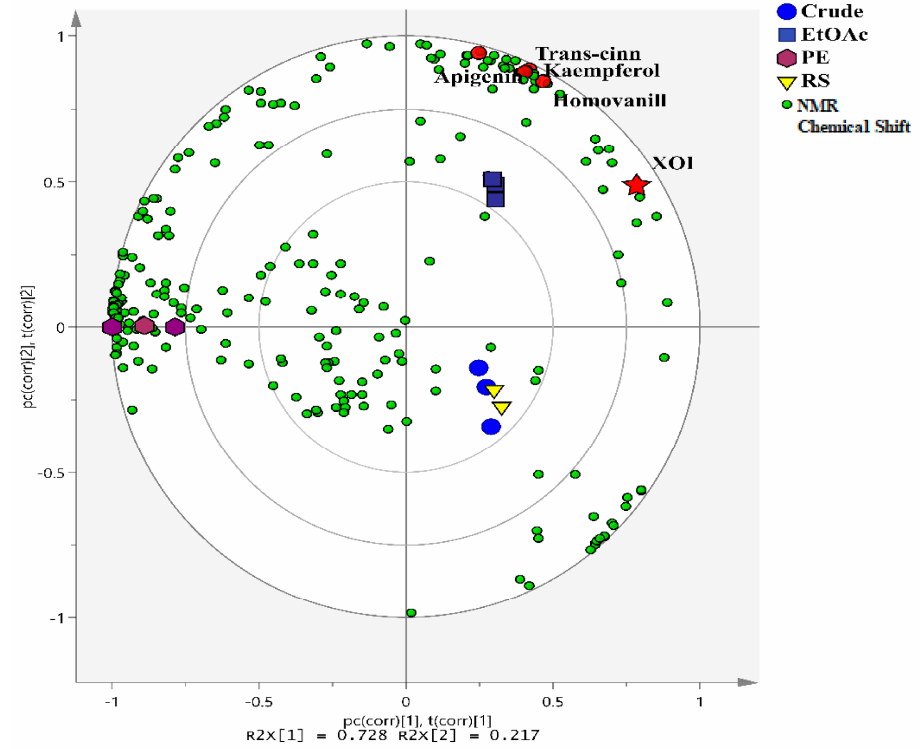
Figure 1. PLS biplot regression analysis describing the relationship between different fractions and XO inhibitory activity. Each point represents an individual NMR chemical shift, red star represents the Y-variable, and the four metabolites responsible for XOI activity are represented by red color circles. EtOAc, ethyl acetate fraction; PE, petroleum ether fraction; RS, residual fraction; XOI, xanthine oxidase inhibitory activity.